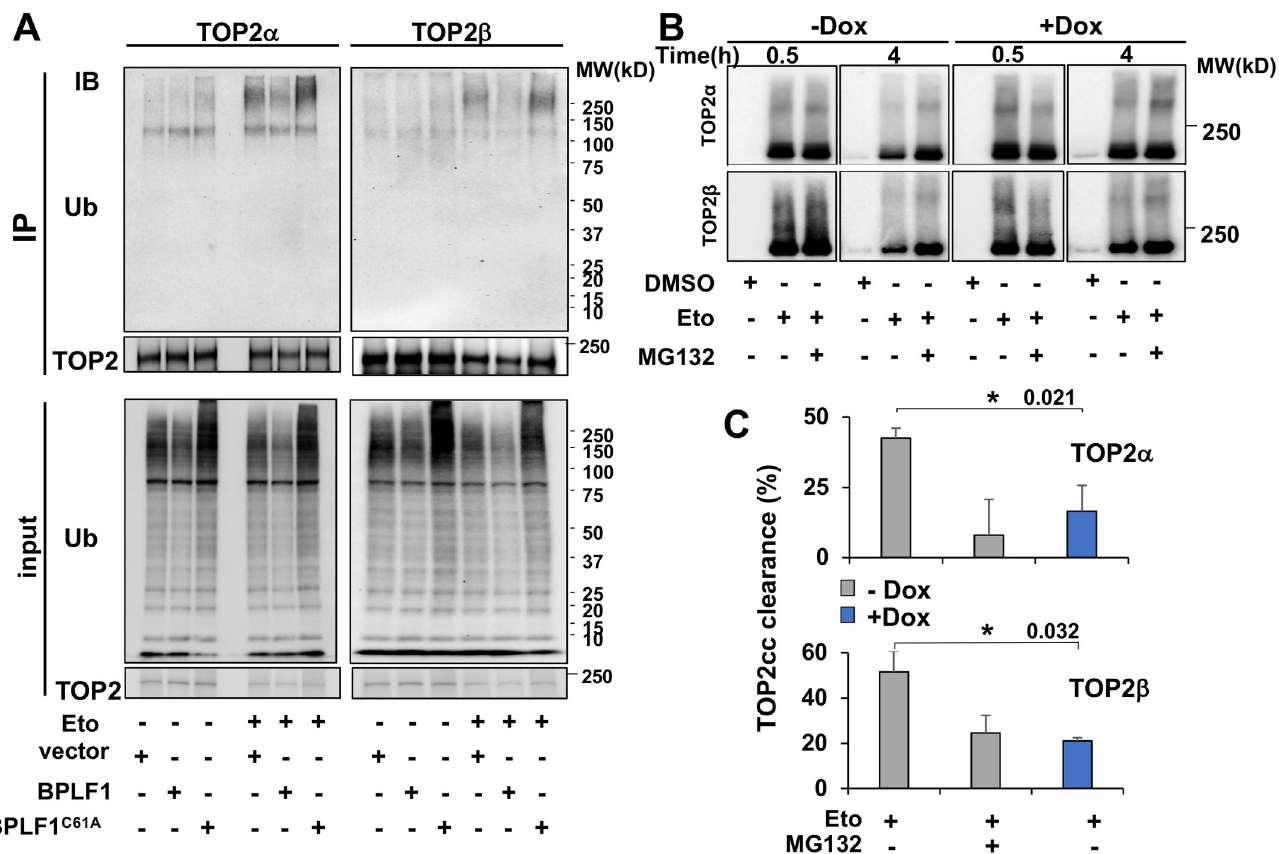
Fig 2. BPLF1 deubiquitinates TOP2 and stabilizes TOP2ccs. (A) HEK293T cells were transiently transfected with plasmids expressing FLAG-BPLF1, FLAG-BPLF1-C61A, or the FLAG empty vector, and aliquots were treated with 40 μ M Etoposide for 30 min. TOP2 α and TOP2 β were immunoprecipitated from cell lysates prepared under denaturing conditions in the presence of DUB inhibitors and western blots were probed with antibodies to TOP2 α , TOP2 β and ubiquitin. The expression of catalytically active BPLF1 inhibits the ubiquitination of TOP2 α and TOP2 β induced by Etoposide treatment. Western blots from one representative experiment out of three are shown in the figure. (B) HEK-rtTA-BPLF1 cells were treated with 1.5 μ g/ml Dox for 24 h followed by treatment with 80 μ M Etoposide for the indicated time with or without the addition of 10 μ M MG132. RADAR assays were performed as described in Materials and Methods and TOP2 trapped in 10 μ g DNA was detected in western blots using antibodies to TOP2 α or TOP2 β . Trapped TOP2 appears as a major band of the expected size and a smear of higher molecular weight species. The intensity of the trapped TOP2 α and TOP2 β smears decreased over time in control untreated cells due to proteasomal degradation, while the decrease was significantly reduced upon expression of BPLF1 in Dox treated cells. Western blots from one representative experiment out of two are shown in the figure. (C ) The intensity of the TOP2 smears was quantified using the ImageJ software. Clearance was calculated as 1- (intensity of the smears after treatment for 4 h/intensity of the smears after treatment for 30 min) x100. Treatment with MG132 reduced the clearance of TOP2ccs in BPLF1 negative cells and a similar reduction was achieved by expression of BPLF1 in Dox treated cells. The mean ± SD of two independent experiments is shown in the figure. Statistical analysis was performed using Student’s t-test. � P �